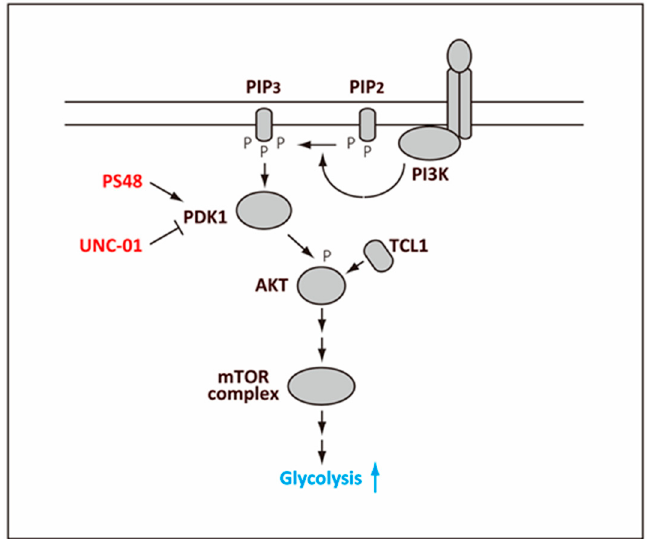
Figure 3. Regulation of glycolysis by AKT. Phosphoinsitide 3-kinase (PI3K) associated with a receptor, such as a receptor tyrosine kinase, phosphorylates phosphatidylinositol (4,5)-bisphosphate (PIP2) to generate phosphatidylinositol (3,4,5)-triphosphate (PIP3). PIP3 then binds and activates 3-Phosphoinositide-dependent protein kinase-1 (PDK1), which then activates AKT by phosphorylation. The phosphorylated AKT elicits activation of the mTOR complex, which leads to higher glycolysis. Leukemia/lymphoma 1 (TCL1) binds to AKT directly and promotes phosphorylation of AKT.